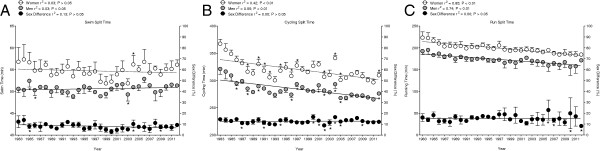
Change in performance of the ten fastest swimmers, cyclists, and runners. (A) The ten fastest swimmers, (B) the ten fastest cyclists, and (C) the ten fastest runners at the Ironman Hawaii. An asterisk indicates values which are significantly different from the previous one.